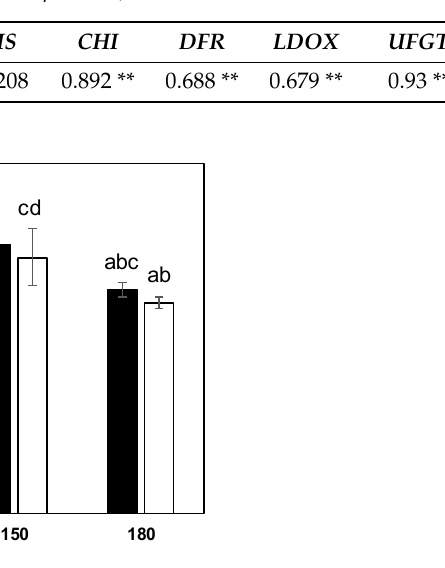
Figure 4. Total phenolic content at different development stages of “Giovanna” (dark-blue) and “Grazia” (white) fruit. Error bars represent the standard error of the mean of three biological replicates. Every replication consisted of 40 berries. Different letters represent statistically significant differences with Tukey’s B-test ( p < 0.05). Tukey’s B-test was carried out by comparing all means calculated at different DAFs for both cultivars.